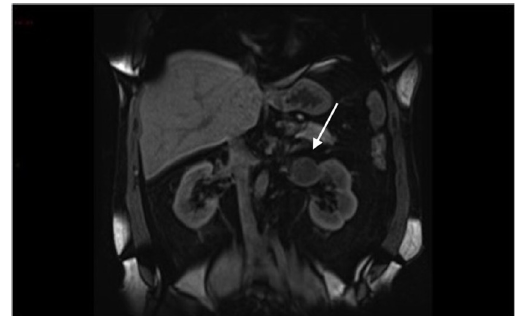
Figure 3 - Coronal T1 pre-contrast imaging – the lesion is hypointense to adjacent renal parenchyma (arrow).